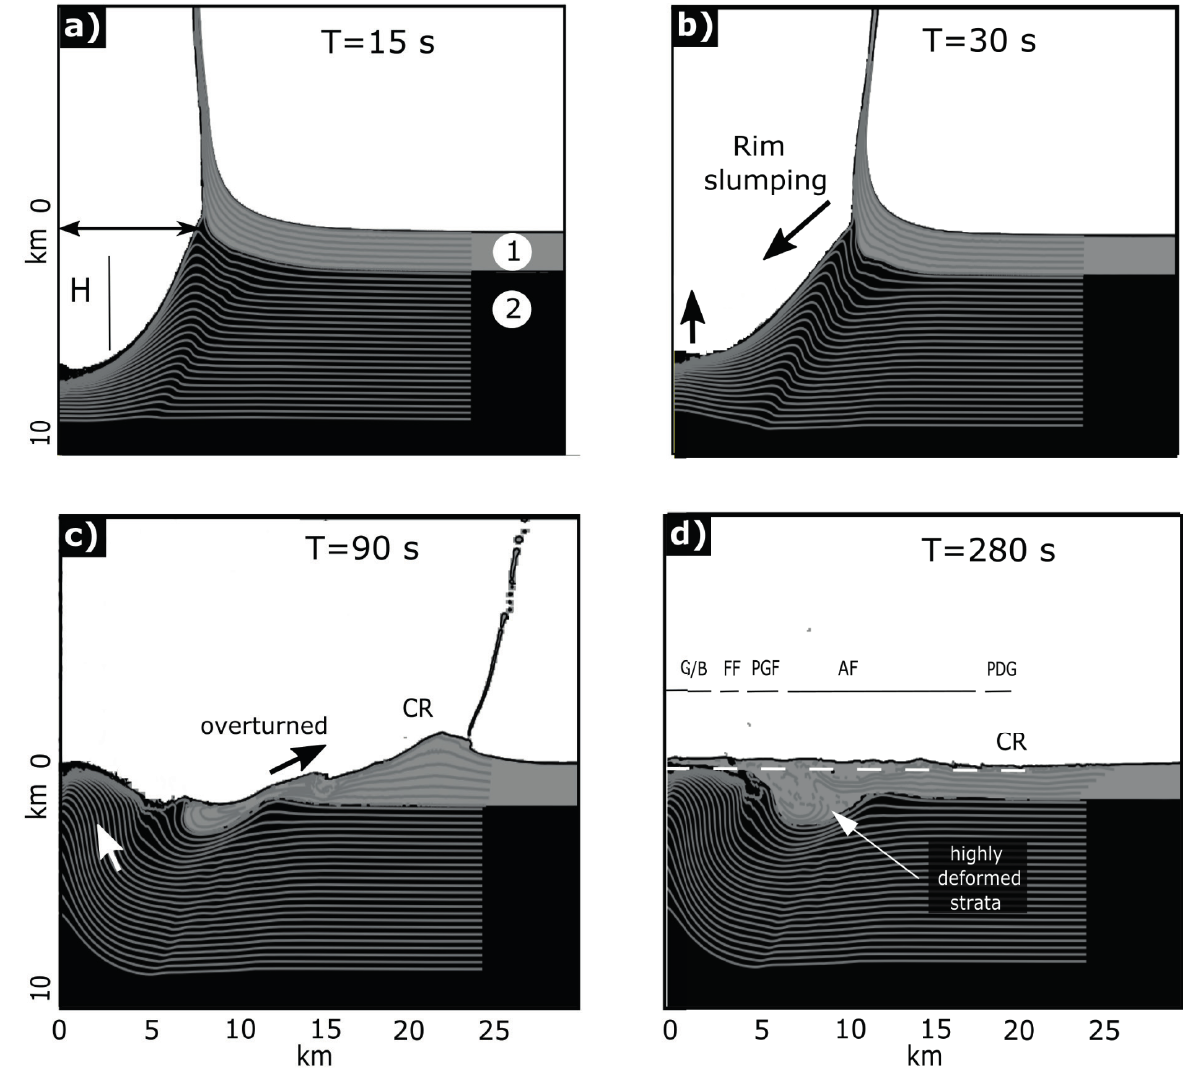
Figure 5. Best-fi tting model for the impact event, showing the right-hand side of the model. (a) 15 sec after the impact, the crater reaches ~16 km diameter and ~7 km depth. (b) After 30 s, the formation of the central uplift begins. (c) The basement rises and remains exposed after 90 sec. (d) After 280 s, the structure reaches gravitational stability. CR = crater’s rim. Number 1 corresponds to sedimentary rocks, and number 2 to the granitic basement. The solid tracer lines connect the positions of the tracer particles that marked the center of each computational cell at the beginning of the simulation, following the paths of the material in that cell. Where the separation between tracer particles that were originally horizontally adjacent to each other exceeds ten times the initial separation (250 m), there is no line connecting these points. The extreme deformation in the sedimentary collar around the central uplift is highlighted by folding and discontinuities in the tracer lines at radial distances of 5-15 km. A similar deformation is observed in the real strata of the Furnas